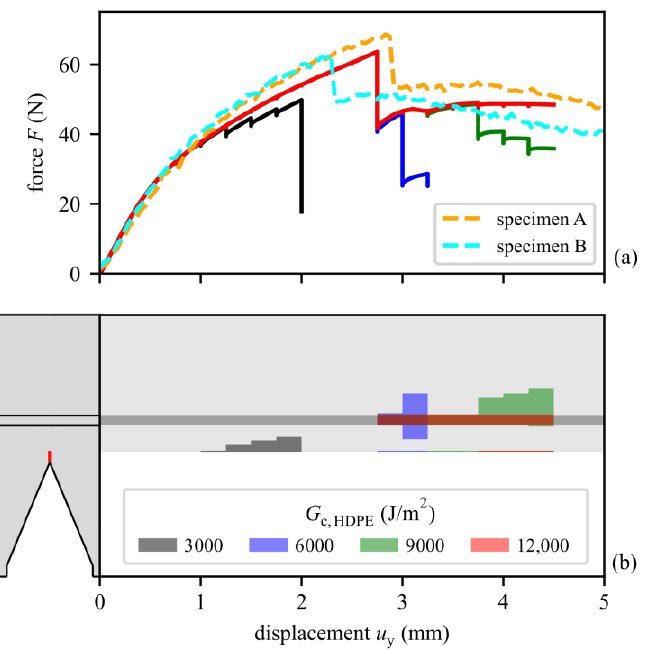
Figure 7. ( a ) Forces plotted over the displacement for the layered SENB specimens for both the numerical models and the experiments. For the simulation results, the critical energy release rate G c,HDPE is varied between 3000 and 12,000 J/m 2 . Frictionless contact is used between roller and specimen. Additionally, ( b ) shows the corresponding cracked regions in the specimen as dark gray, blue, green, and red areas. For G c,HDPE = 3000 J/m 2 , the initial crack grows into the HDPE material. For higher G c,HDPE values, there is very small growth in the initial crack, and at a displacement u y of 2.75 mm, a crack initiates in the EVOH layer and grows through the whole EVOH layer. Figure 7b plots the cracked regions over the applied displacement as dark gray, blue, green, or red regions. The EVOH interlayer is drawn as a dark gray region. For example, the force–displacement curve in Figure 7a for a G c,HDPE value of 3000 J/m 2 shows some kinks that start at a displacement of 1 mm. These kinks correspond to a growing crack in the HDPE material at the initial notch tip, as illustrated in Figure 7b as a dark gray area. For a displacement of 1.8 mm (left dashed blue line in the top diagram), a pictogram shows that the dark gray area corresponds to a crack from the bottom that is already approaching the EVOH layer. This is not representative of the real experiments, indicating that this value of G c,HDPE is too low. For higher values of G c,HDPE , the first considerable cracks evolve in the EVOH layer and grow into the HDPE material from there. Since the fracture toughness and strength of the EVOH is not varied, the drop in the F - u curve is the same for G c,HDPE ≥ 6000 J/m 2 . For a displacement of 4.25 mm and G c,HDPE = 9000 J/m 2 , another pictogram shows how the initial crack has grown only to a small extent, but the crack that has initiated in the EVOH layer has grown further into the HDPE material, aligning with experimental observations. The overall shape of the F - u curves of the model and the experiments fit well for values of G c,HDPE ≥ 6000 J/m 2 . The difference between the two experimental curves indicates the scattering in the experiment, which can be due to initial defects in the material, the variation in the geometry of the specimens, and the variation in the initial notch length after broaching. The shape of the experimental curves after the failure of the EVOH layer indicates that the suited critical energy release rate G c,HDPE in the model is between 9000 and 12, 000 J/m 2 . For G c,HDPE = 9000 J/m 2 , there is additional